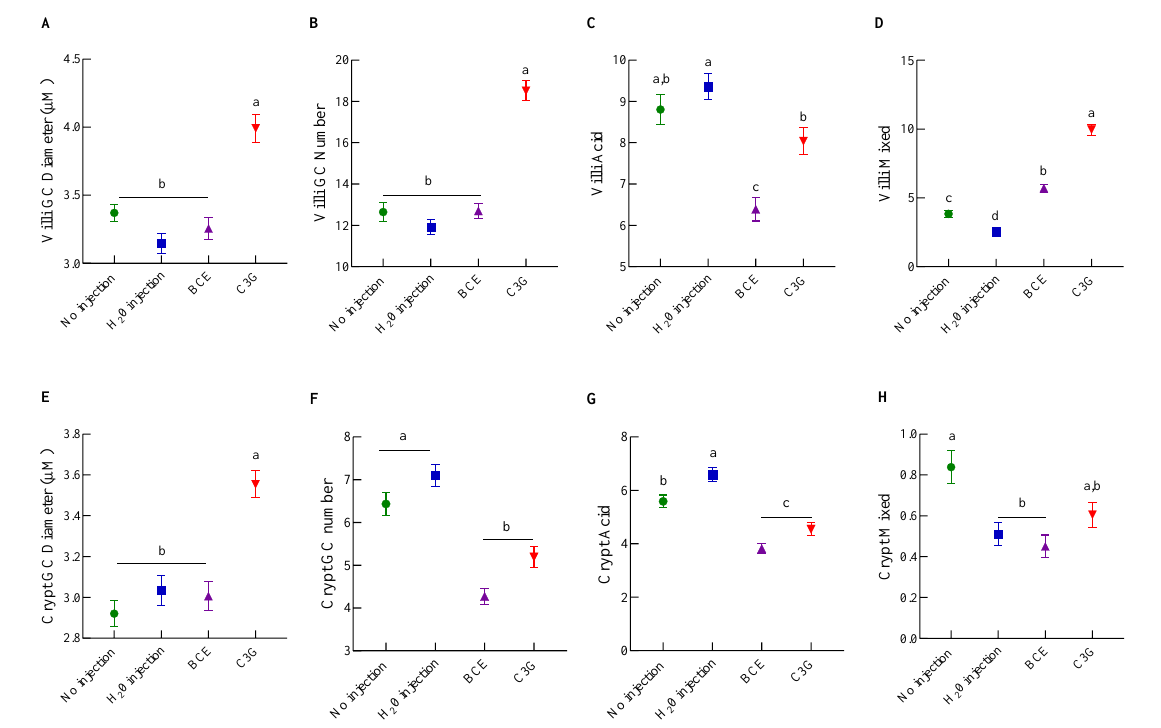
Figure 4. Effect of intra-amniotic administration of black corn extract on goblet cells: ( A – D ): villi goblet cell characteristics; ( E – H ) crypt goblet cell characteristics. Values are means ± SED, n = 3 ani- mals/group. Treatment groups not indicated by the same letter are different ( p < 0.05) by Kruskal– Wallis and a post-hoc of Dunn’s test. Mixed goblet cells are acidic and neutral. BCE: black corn extract; C3G: cyanidin-3-glucoside; GC: goblet cell.